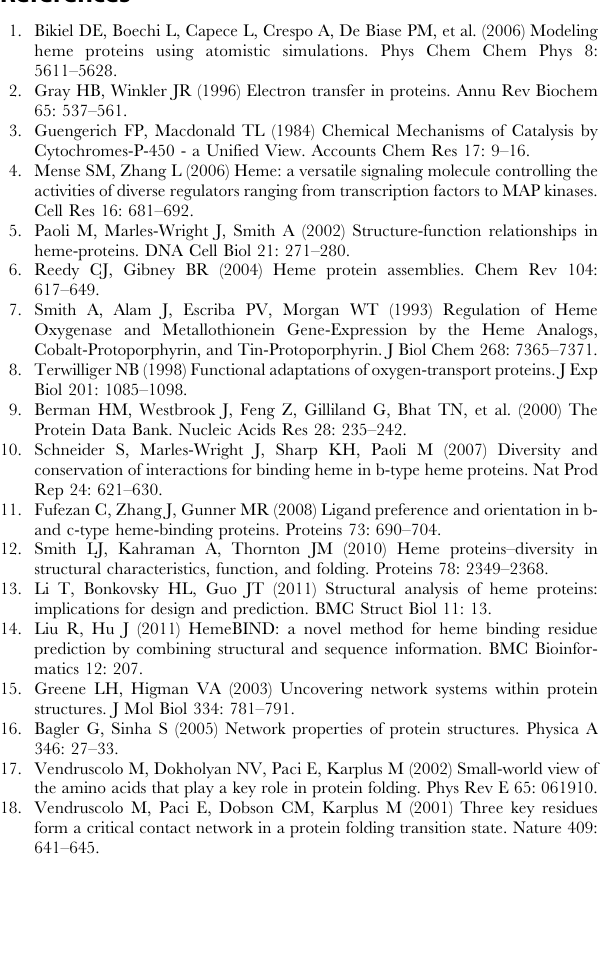
Table S5 Comparison of the prediction performance for individual apo